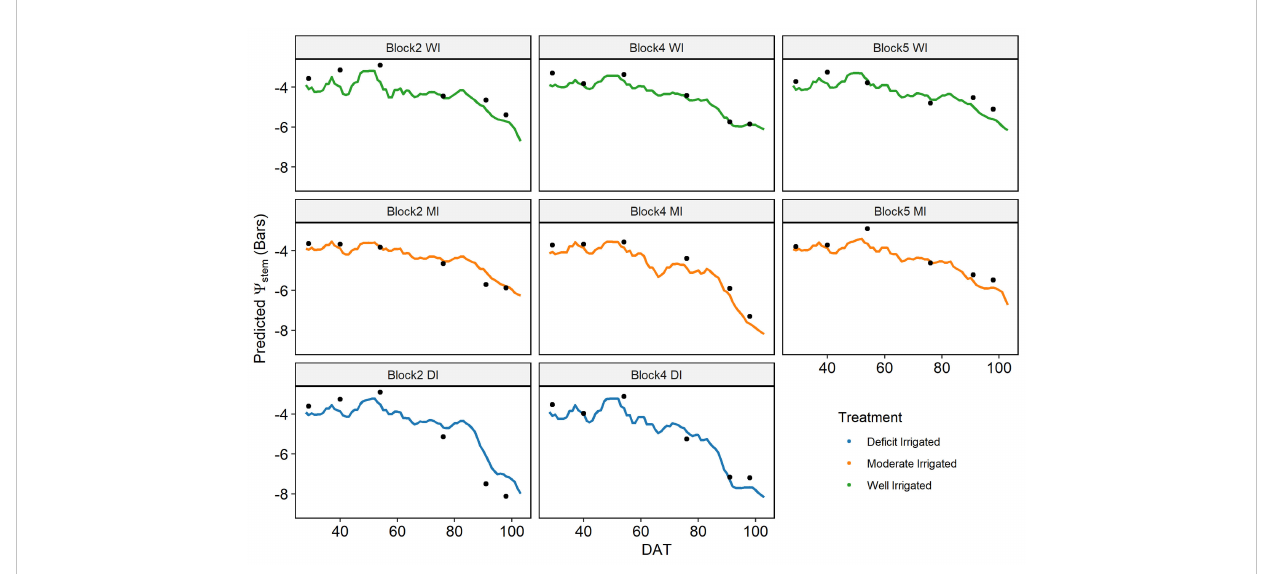
FIGURE 9 Temporal dynamics of the predicted daily mid-day stem water potential ( y stem) from the proximal sensor-based random forest model during the entire growing season. Field-measured y stem values are shown as solid dots.